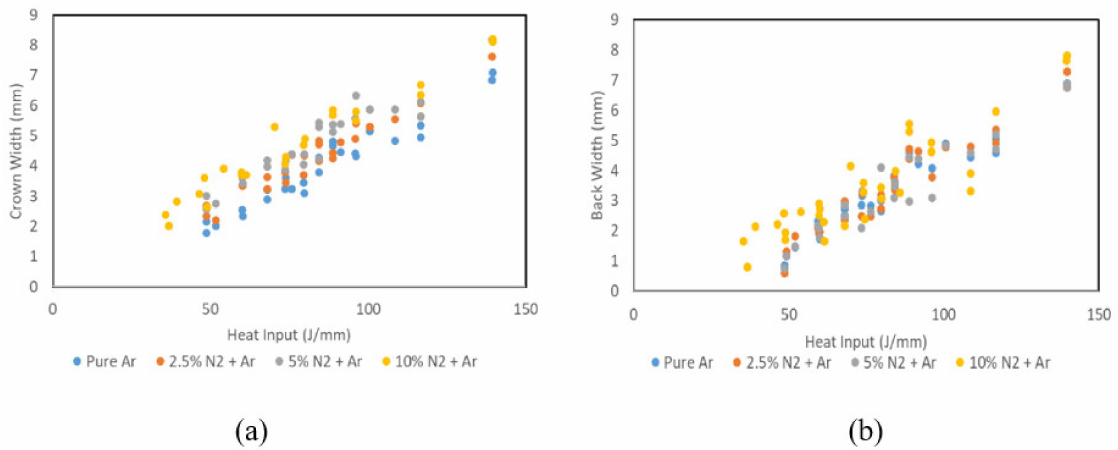
Figure 8. Comparison of ( a ) CW and ( b ) BW for welds made heterogeneously using pure Ar and different values of N 2 as the shielding gas on 1.5 mm thick sheets.